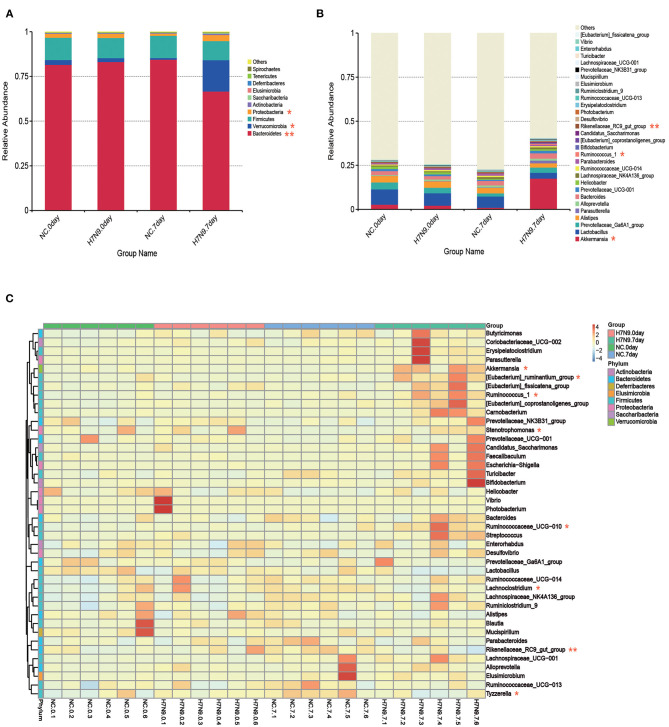
Fecal microbiota abundances at the phylum and genus levels for H7N9-infected mice and healthy controls. The relative abundance of the top (A) 10 phyla and (B) top 30 genera in each group. (C) Hierarchically clustered heatmap analysis at the genera level of each sample; the relative values for bacterial genera are indicated by color intensity. Statistical significance was tested by a Wilcoxon–Mann–Whitney test. *P < 0.05 and **P < 0.01.